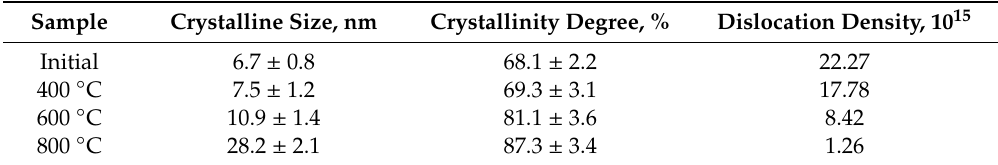
Table 4. Data on alterations in the main crystallographic